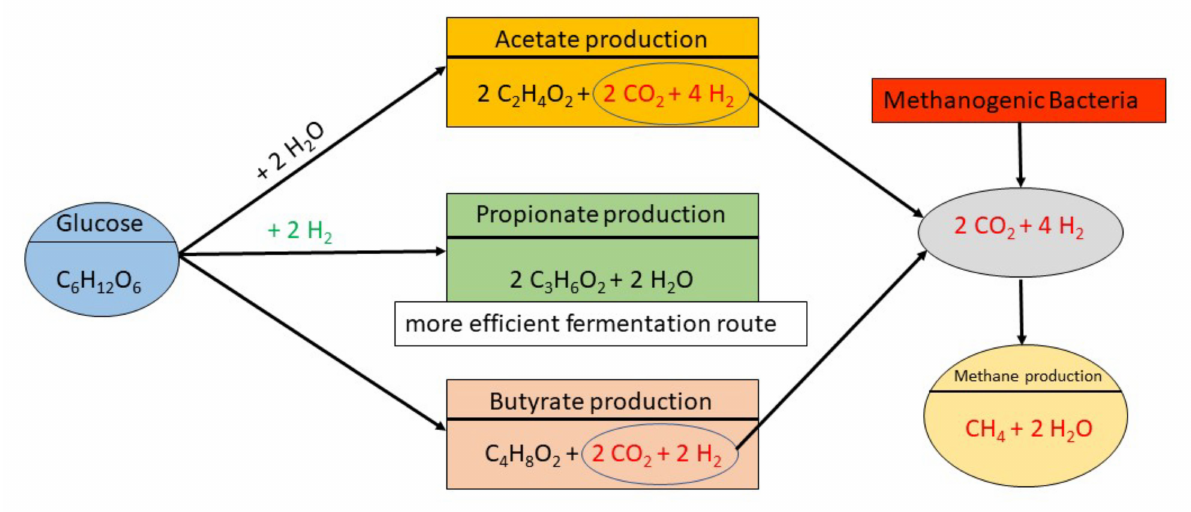
Figure 1. Ruminal fermentation routes and short-chain fatty acids (SCFA) and methane production. Adapted from Bergman [39] and NASEM